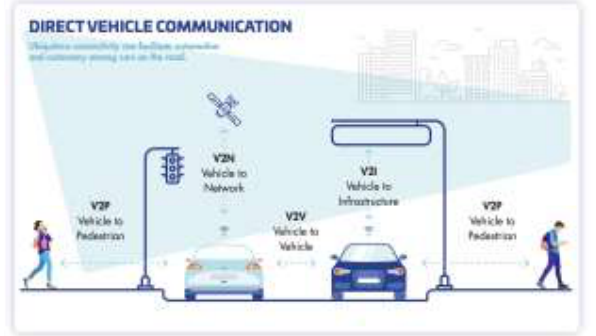
Figure 1. Direct vehicle